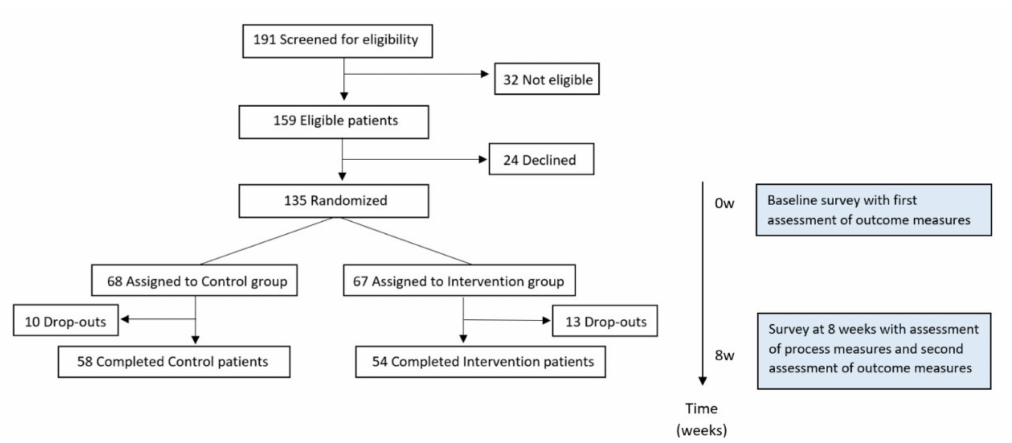
Figure 2. Diagram showing flow of patients through the clinical trial.